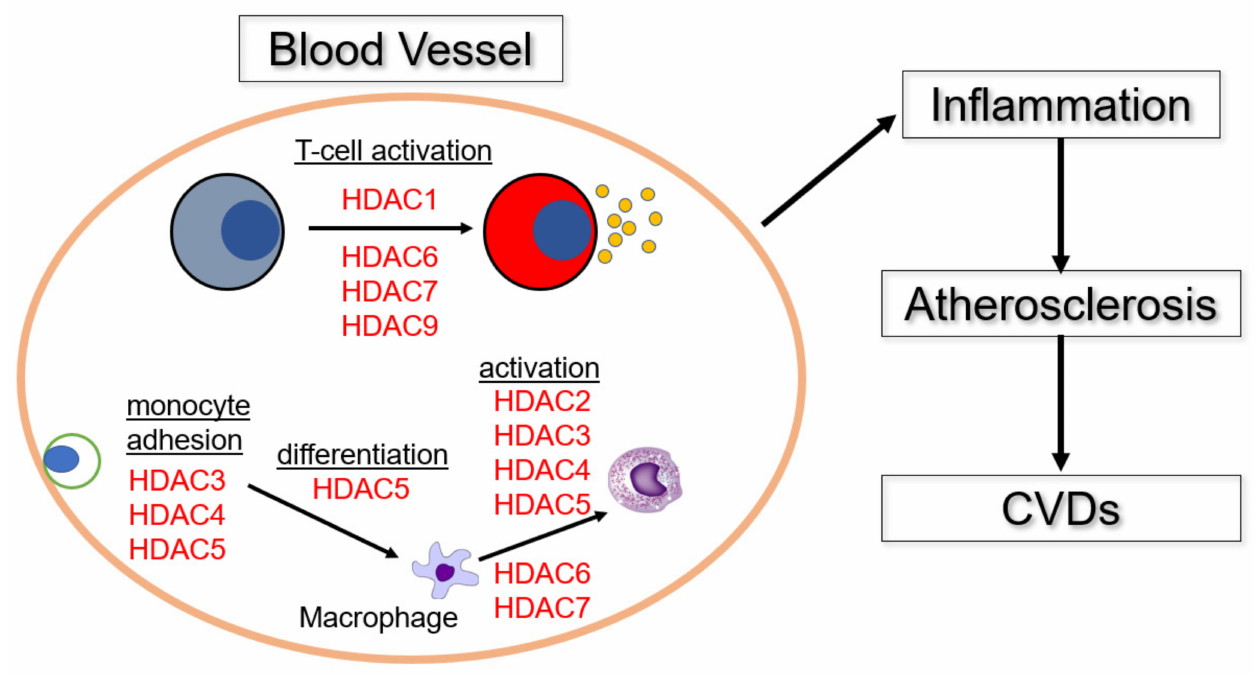
Figure 2. The roles of HDACs in inflammation and development of CVDs. HDAC3, 4, and 5 promote migration and adhesion of monocytes to inflammatory sites [29,30,63,64], followed by induction of macrophage differentiation by HDAC5 [65]. The differentiated macrophages are activated by HDAC 2, 3, 4, 5, 6, and 7 [28,32,40,66,67]. And HDAC 6, 7, 8, and 9 promote T cell activation at inflammatory sites